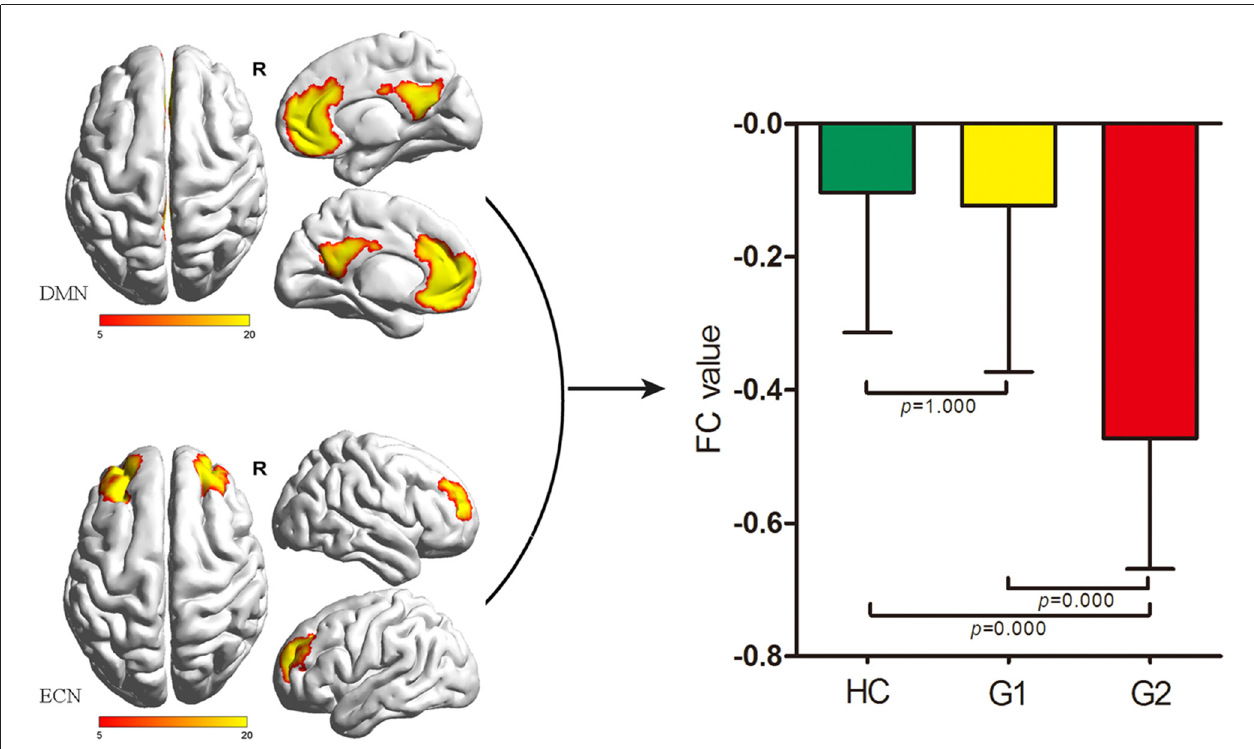
FIGURE 1 | Comparisons of inter-network FC alterations between the ECN and DMN among HC, G1 and G2. G2 exhibited decreased FC between the ECN and DMN compared with G1 and HC (both p = 0.000, Bonferroni corrected); G1 showed no significant difference of FC between the ECN and DMN compared with HC. DMN, default-mode network; ECN, executive control network; FC, functional connectivity; HC, healthy control; G1, subgroup 1; G2, subgroup